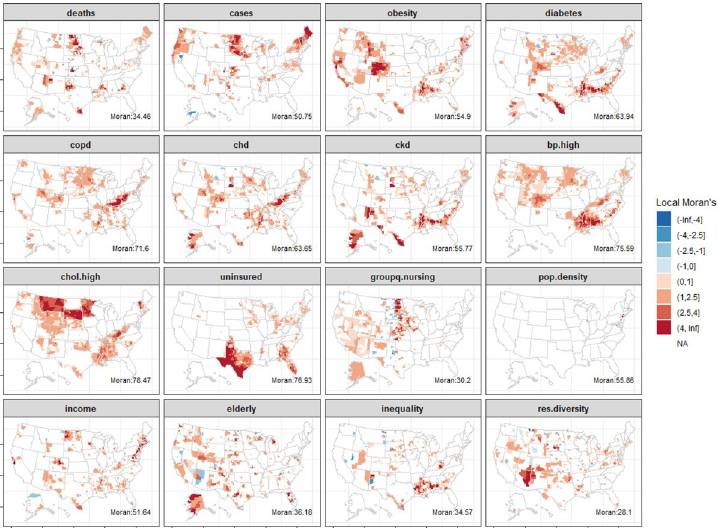
Fig 3. Local Moran’s I statistic for spatial autocorrelation for all measures and outcome. Only counties where the statistic is significant ( p < 0.05) are shown. Significance is tested under Pr[I–E(I)/Var(I)] as given by Anselin [44]. Global Moran’s I statistic is denoted by the label in each subpanel and found to be statistically significant for all variables. Maps generated with usmap R package [28].